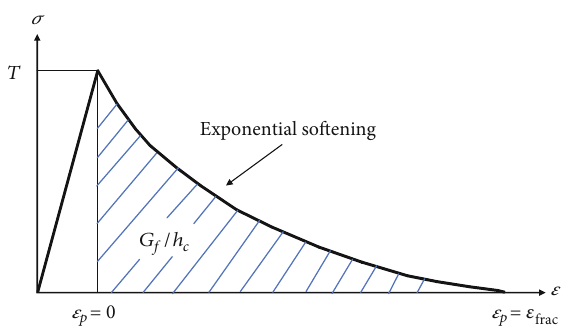
Figure 1: Exponential stress-strain curve for uniaxial